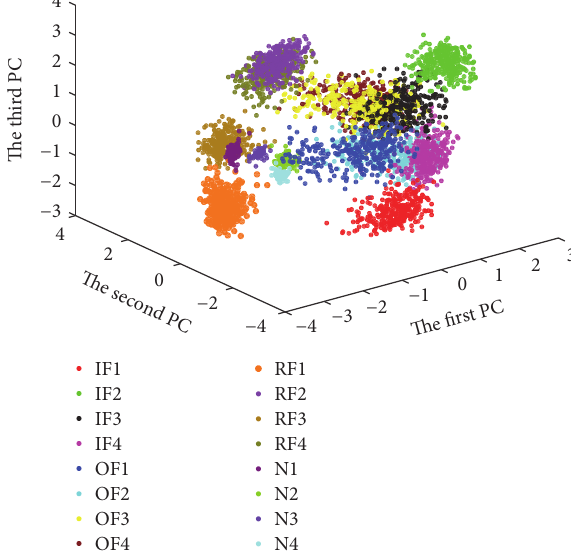
Figure 9: Scatter plots of principal components for fault features with traditional DNN